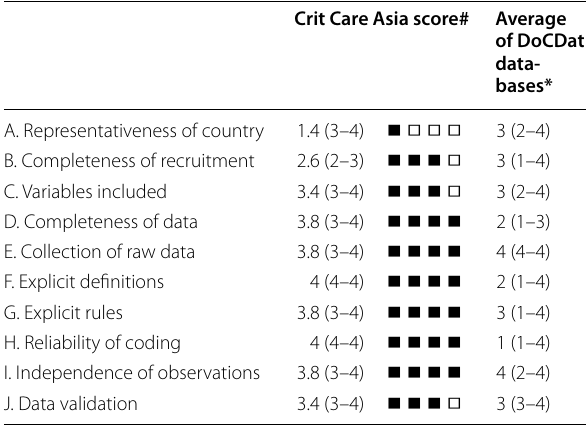
Table: Aggregate assessment of the registries in the 7 countries according to the Directory of Clinical Databases (DocDat) criteria. Crit Care Asia